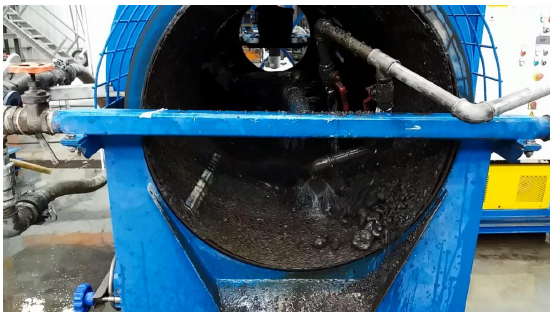
Figure 15. Separation of coarse materials in the rotating drum (trommel).